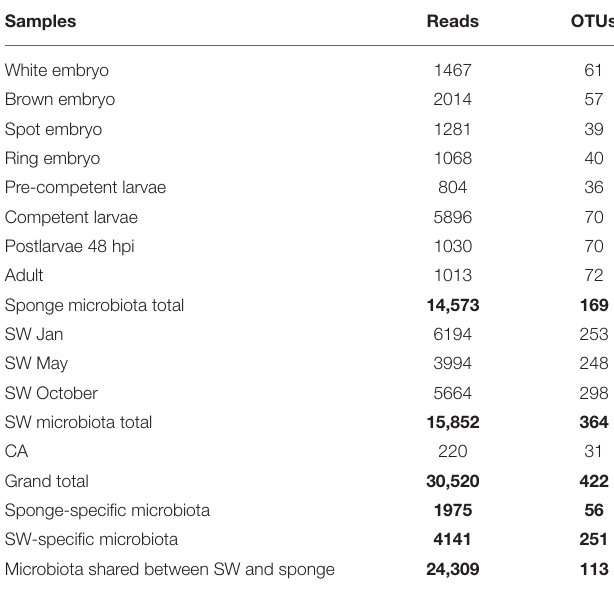
TABLE 1 | 16S rRNA gene amplicon sequence summary for sponge and environmental samples, based on non-rarefied, normalized datasets. Samples